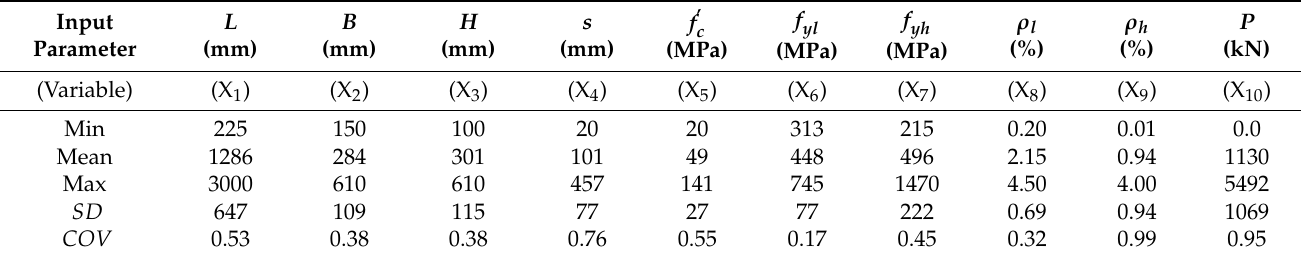
Figure 1. Configurations and properties of rectangular RC columns. Table 1. Summary of input parameters of